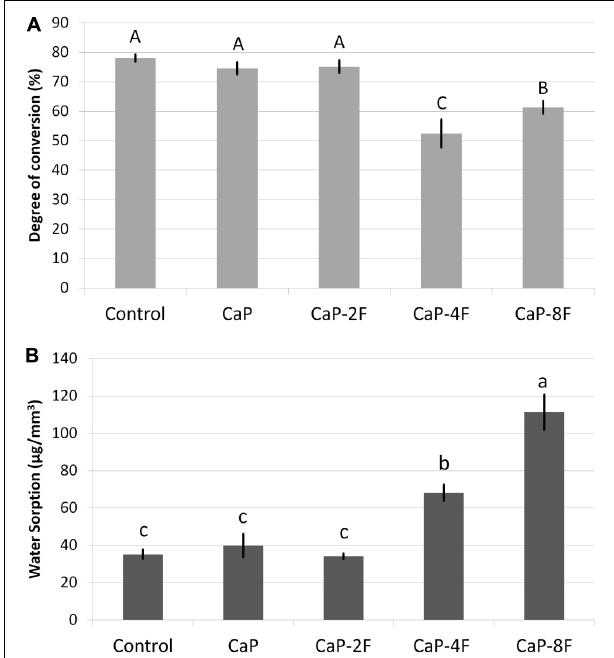
FIGURE 1 | Means (standard deviations) of the degree of conversion (%) in (A) and water sorption ( µ g/mm 3 ) in (B) . Different letters indicate statistical difference ( p < 0.05).